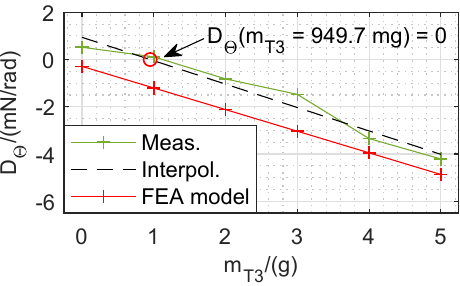
Figure 16. Influence of the trim weight ( m T 8 ) on the tilt sensitivity of the weighing cell close to D (cid:50) = 0.